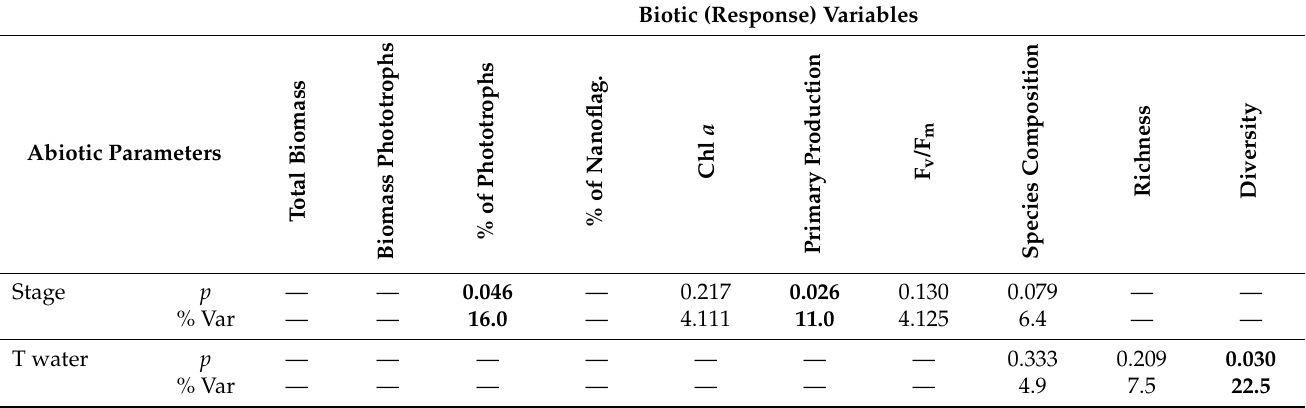
Table 3. Significance level ( p ) and proportion of explained variation (% Var) for predictor included in the final best-fit model. Significant values are highlighted in bold.